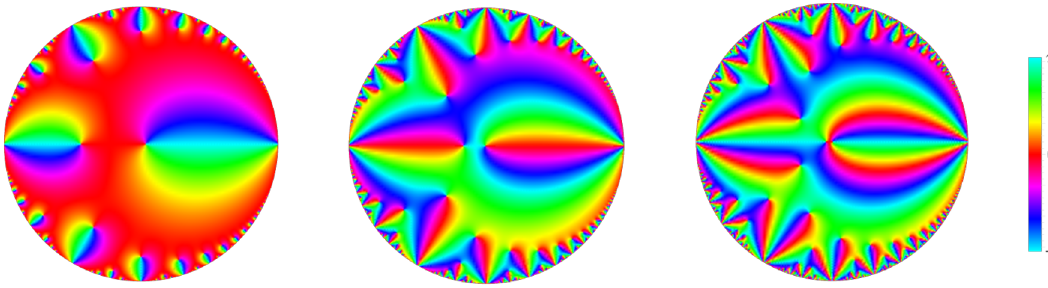
Figure 2 . arg[ E 2 k ( q )] on the unit disk : for [left] E 2 ( q ) , [centre] E 4 ( q ) and [right] E 6 ( q ) . The real and imaginary parts can also be plotted and they show similar structures. Details regarding generating these plots can be found in